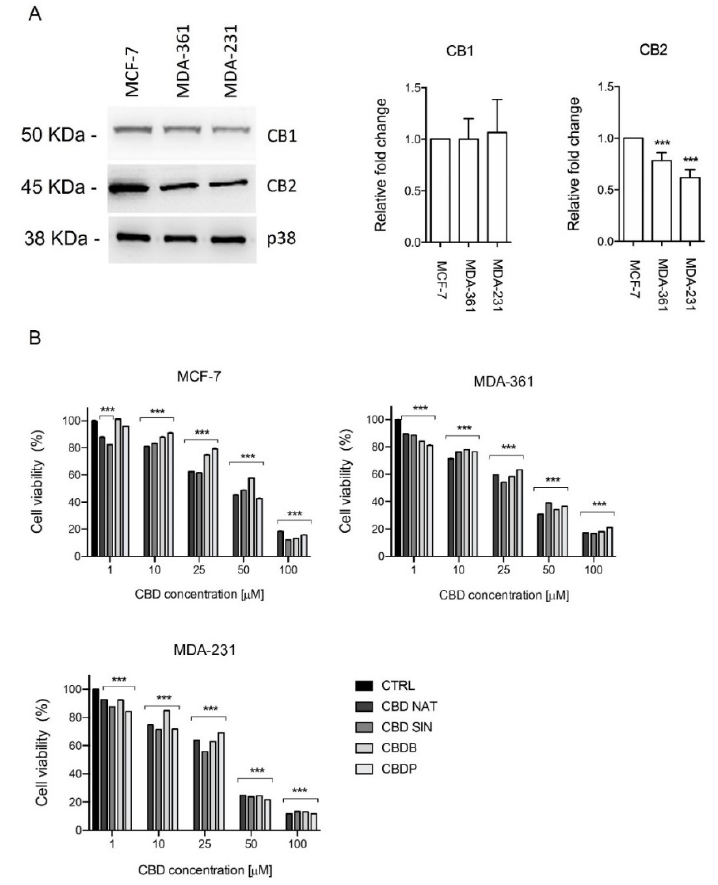
Figure 2. ( A ) Immunoblot analysis of CB1 and CB2 receptors in MCF-7, MDA-MB-361 and MDA- MB-231 breast cancer cell lines, p38 was used as a loading control. Densitometric quantification of the band intensity was normalized to p38 levels using ImageJ. p -value *** < 0.001 by t -test. Effect of cannabinoid treatment on cell viability: ( B ) MCF-7, MDA-MB-361 and MDA-MB-231 cells. All the cell lines were treated with different concentrations of nat CBD, syn CBD, CBDB and CBDP for 24 h; the cell viability was measured using the MTT assay. Values are the mean ± SD. *** p < 0.0001 compared with